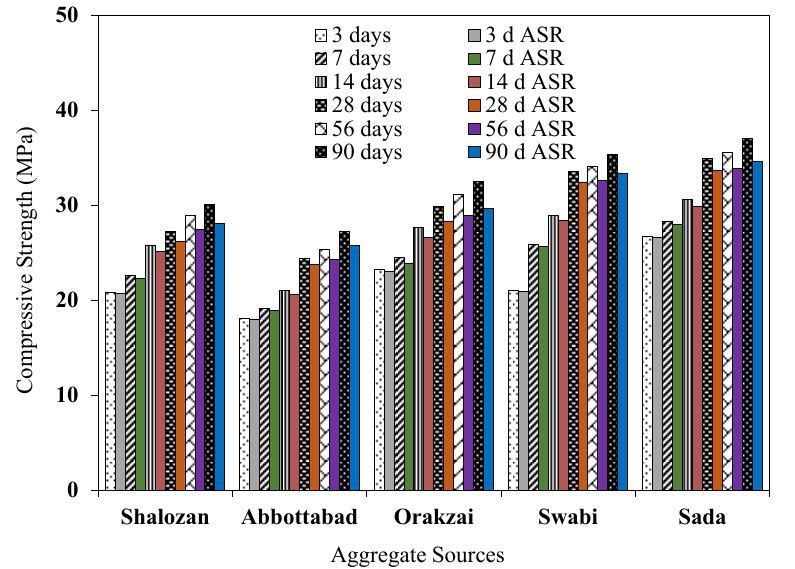
Figure 21. Effect of ASR conditions on compressive strength.